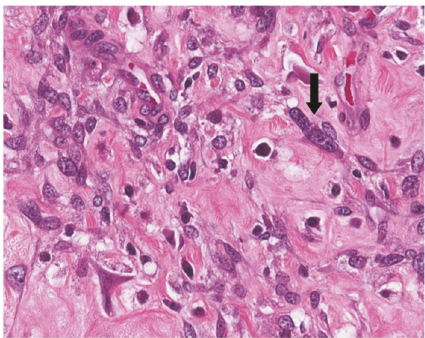
Figure 4: Histology: focal nuclear pleomorphism with scattered single cells showing moderate anisonucleosis, arrow indicating a larger rectangular nucleuswith 4X the nuclearvolume than adjacent tumor cell nuclei (Hematoxylin & eosin,